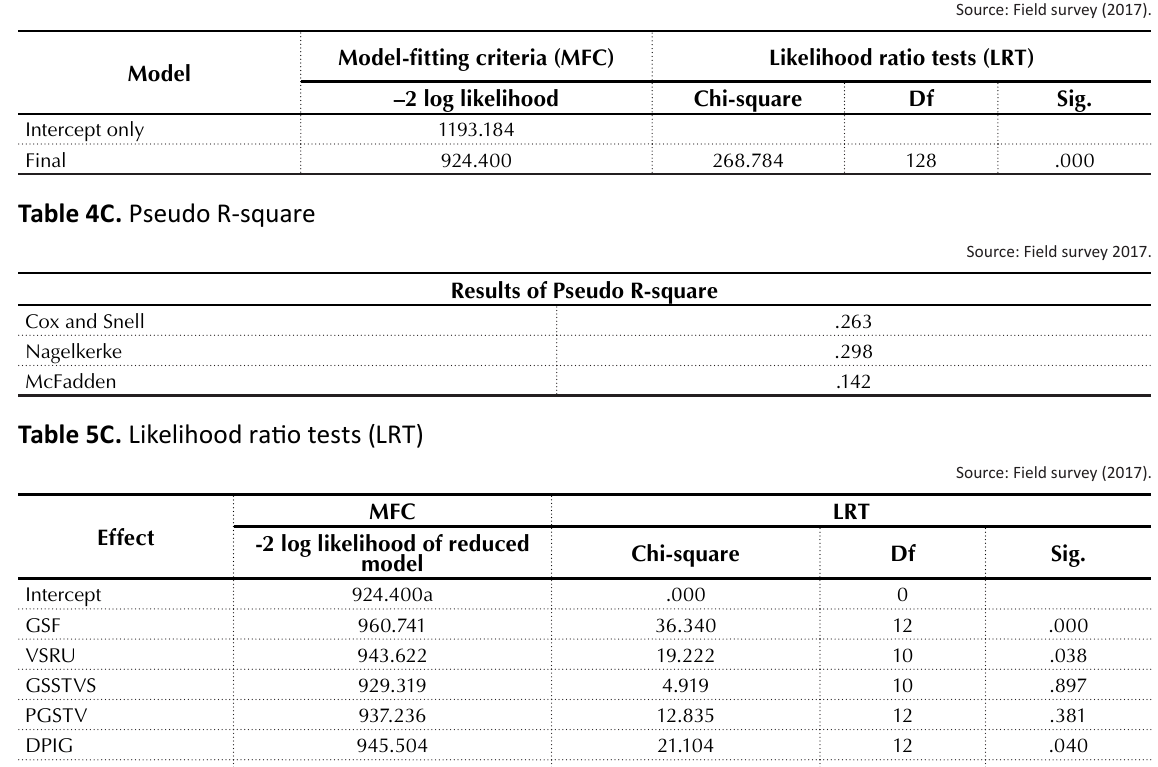
Table 3C. Model fitting information (MFI)